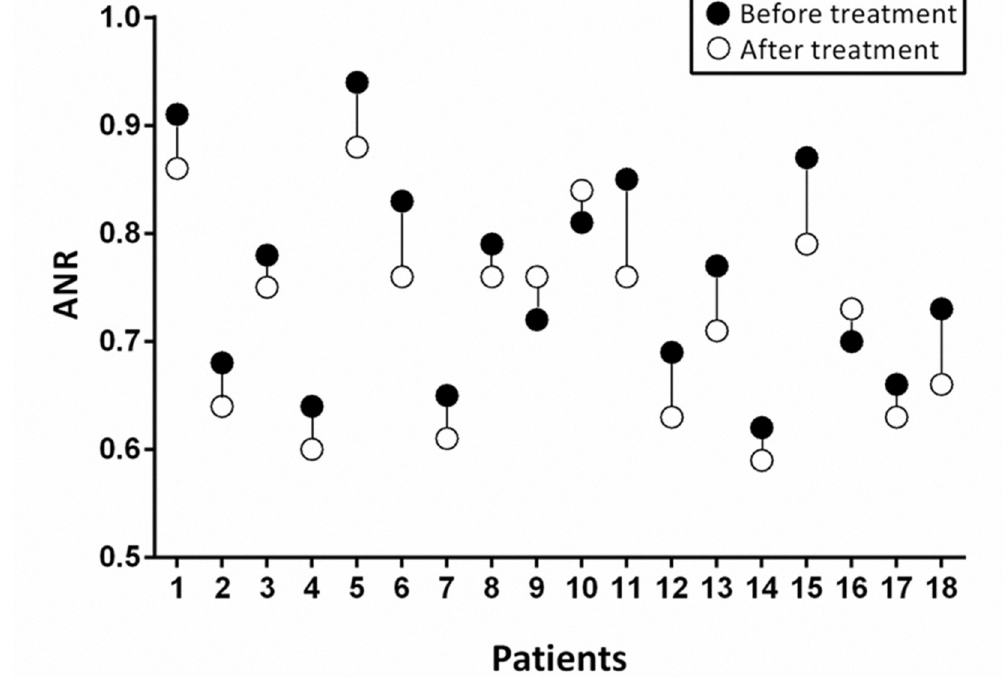
FIGURE 2 - Change of ANR before treatment and after treatment in 18 patients. ANR, adenoidal-nasopharyngeal